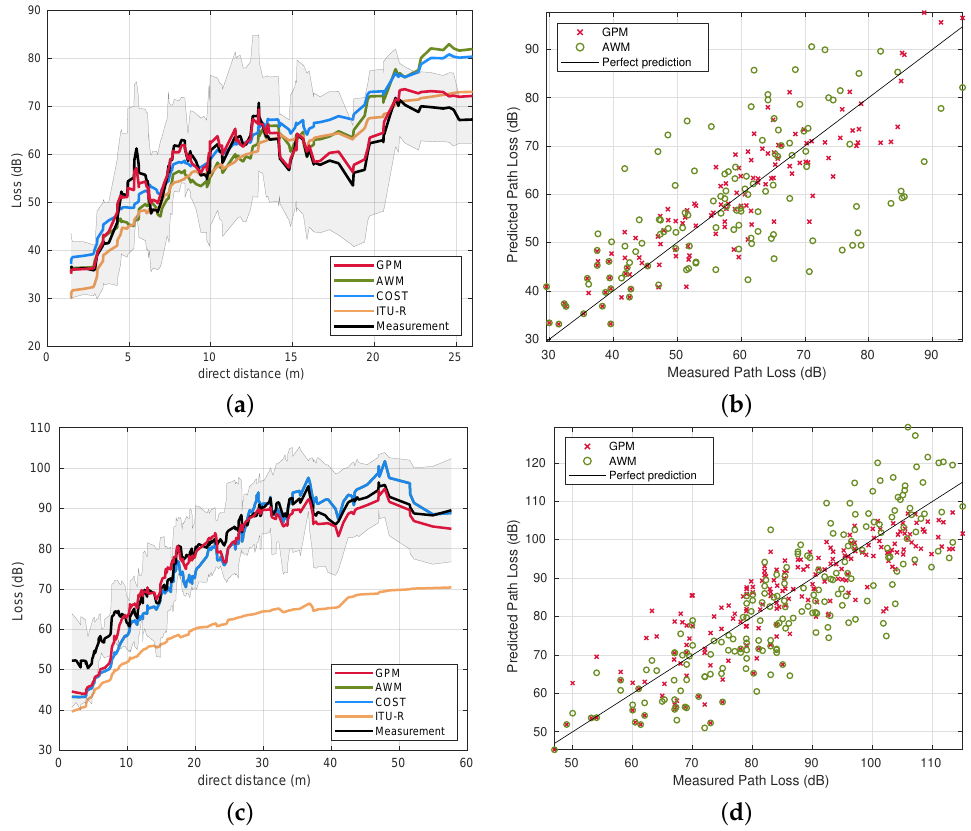
Figure 5. PL is outlined with respect to the direct path distance between TX and RX for all the considered models in ( a ) for the ship environment and in ( c ) for the office environment. A comparison between measured and predicted PL is made visible more explicitly in ( b ) for the ship environment and in ( d ) for the office environment. Table 3. Statistical error analysis summary for the GPM, AWM, COST 231 and ITU-R P.1238.